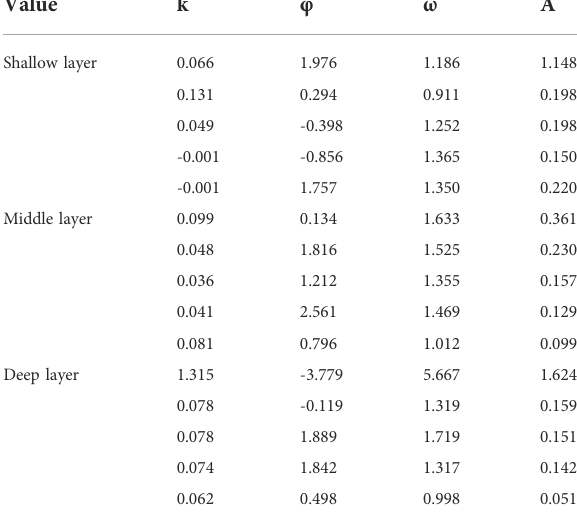
TABLE 3 Values of the fi tting-function